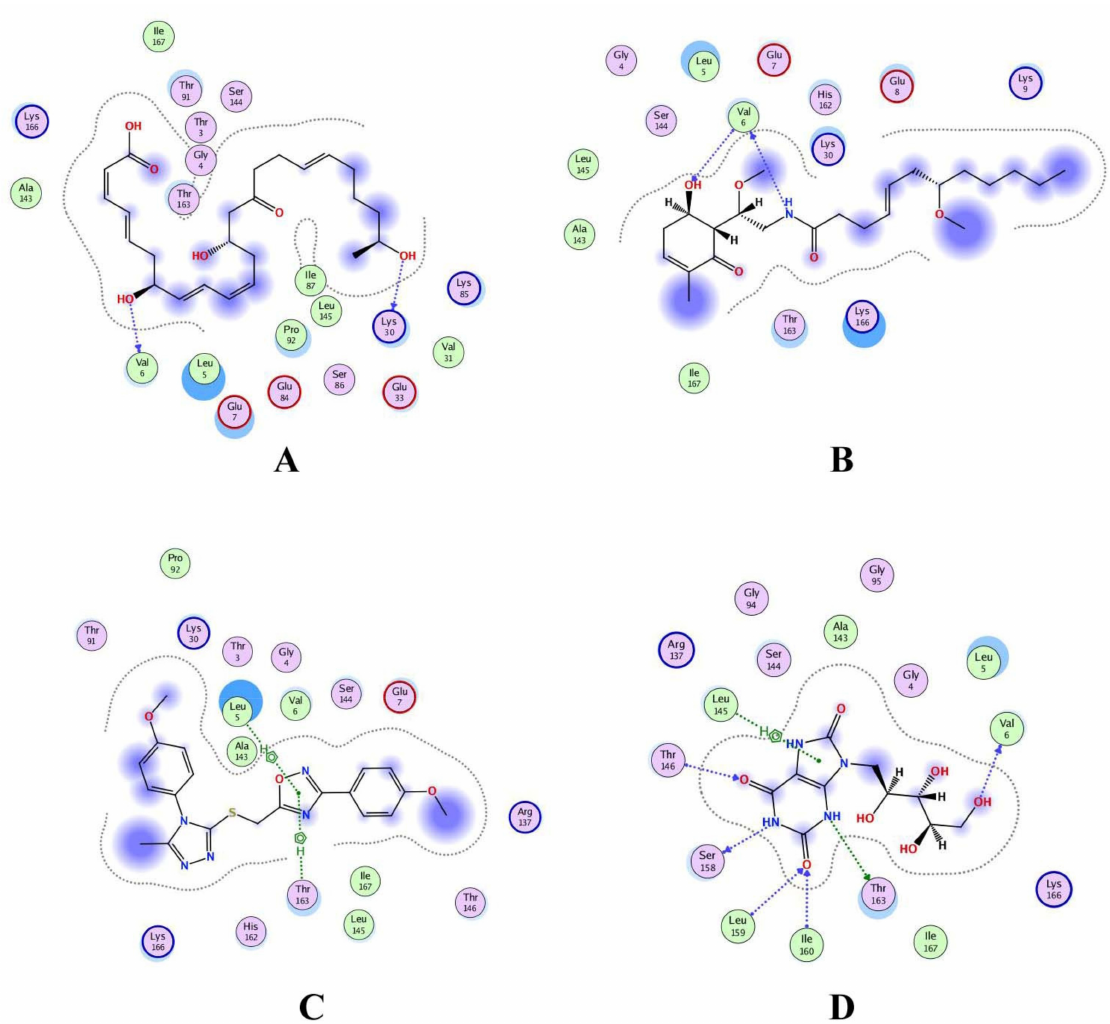
Figure 5. Molecular docking analysis of ( A ) RiS-CMNPD3609, ( B ) RiS-Malyngamide V, ( C ) RiS- ZINC06804365, and ( D )